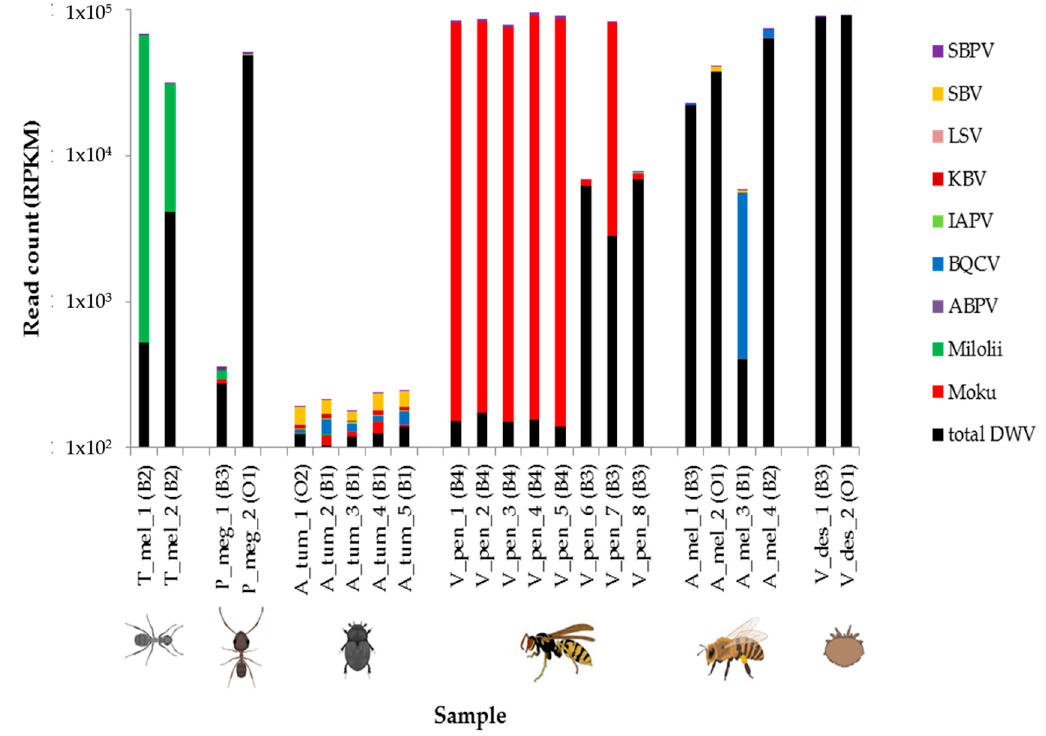
Figure 5. Histograms represent numbers of reads mapping to each of 10 commonly found insect viruses (slow bee paralysis virus: SBPV, sacbrood virus; SBV, Lake Sinai virus; LSV, Kashmir bee virus; KBV, Israeli acute paralysis virus; IAPV, black queen cell virus; BQCV, acute bee paralysis virus; ABPV, Milolii virus, Moku virus and deformed wing virus; DWV) as determined using BLASTn. Read numbers are expressed as reads per kilobase million (RPKM) and are shown on a log-10 scale starting 1 × 10 2 . The samples are positioned according to taxa: ghost ants (T_mel_1–2), big headed ants (P_meg_1–2), small hive beetles (A_tum_1–5), yellowjacket wasps (V_pens_1–8), honey bees (A_mel_1–4), and varroa (V_des_1–2). Apiary locations from where the samples were taken are given after each sample name. Redundancy analysis was conducted ( p < 0.001) to further investigate the variation in viral read count data (log-10) for each sample in the context of species and site explanatory variables. RDA1 and RDA2 together explained 54.8% of the variation, and all variables (sites and species) were significantly di ff erent from the dummy variables ( p < 0.05) (Figure 6). The RDA plot shows groupings by site (colors), as well as demonstrating separation by species, especially “honey bee”, “small hive beetle”, and “yellowjacket